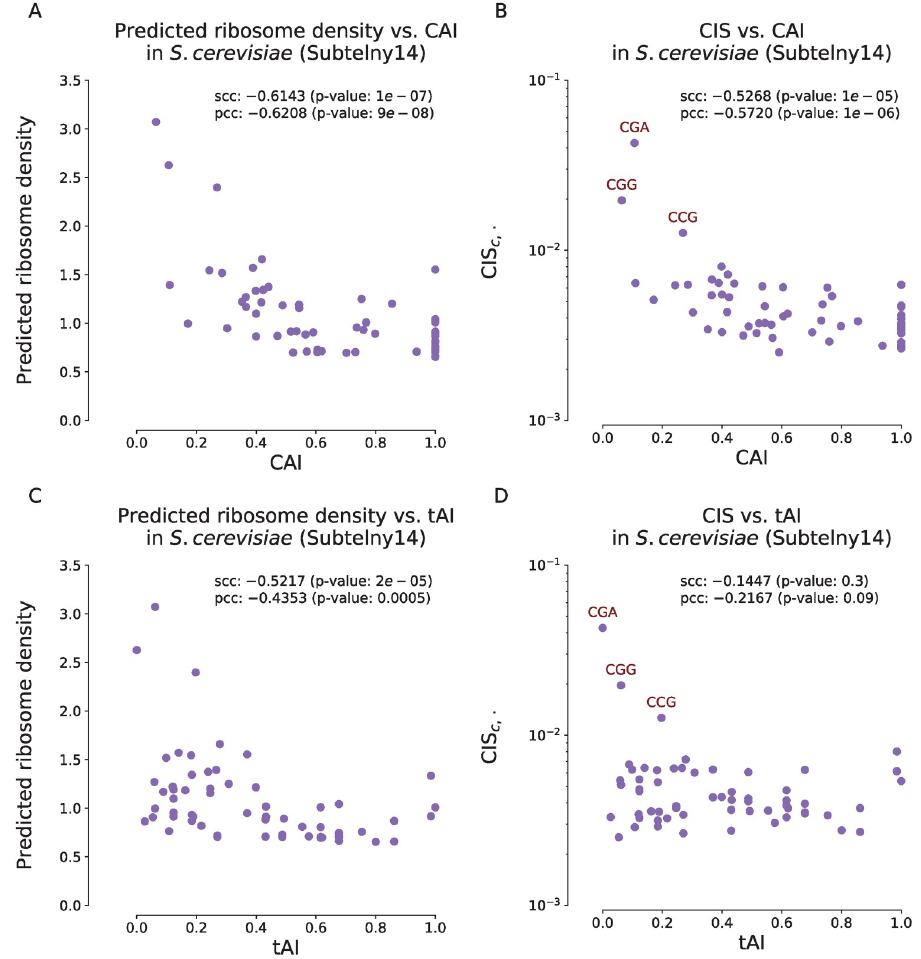
Fig 3. Correlations of ribosome densities and codon impact scores CIS at the A sites with codon adaptation c , � index (CAI) (A–B) and tRNA adaptation index (tAI) (C–D) for the Subtelny14 dataset. (A). Scatter plots of averaged predicted ribosome densities and CAI scores for individual codon types. (B). Scatter plots of CIS c , � values in log scale and CAI scores for individual codon types. (C). Scatter plots of averaged predicted ribosome densities and tAI scores for individual codon types. (D). Scatter plots of CIS c , � values in log scale and tAI scores for individual codon types. scc and pcc stand for the Spearman’s correlation coefficient and the Pearson’s correlation coefficient, respectively. In panel (B) and (D), the rare codons CGA, CGG and CCG are labeled in red.